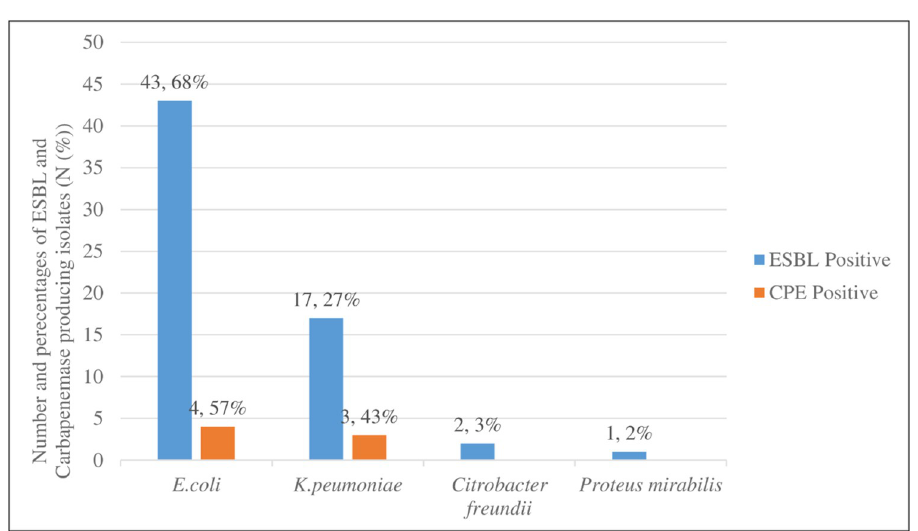
Fig 2. Proportion of ESBL and Carbapenemase-producing Enterobacteriaceae from the total of ESBL, and Carbapenemase positive isolates at the University of Gondar Comprehensive Specialized Hospital and Students’ Cafeteria, Northwest Ethiopia,